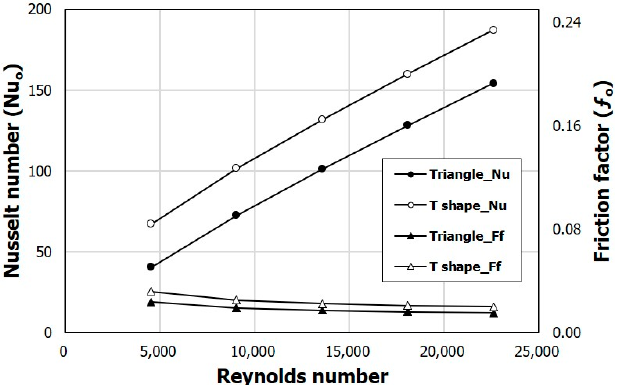
Figure 19. Comparison of performance parameters between T-shaped and triangular ribs.